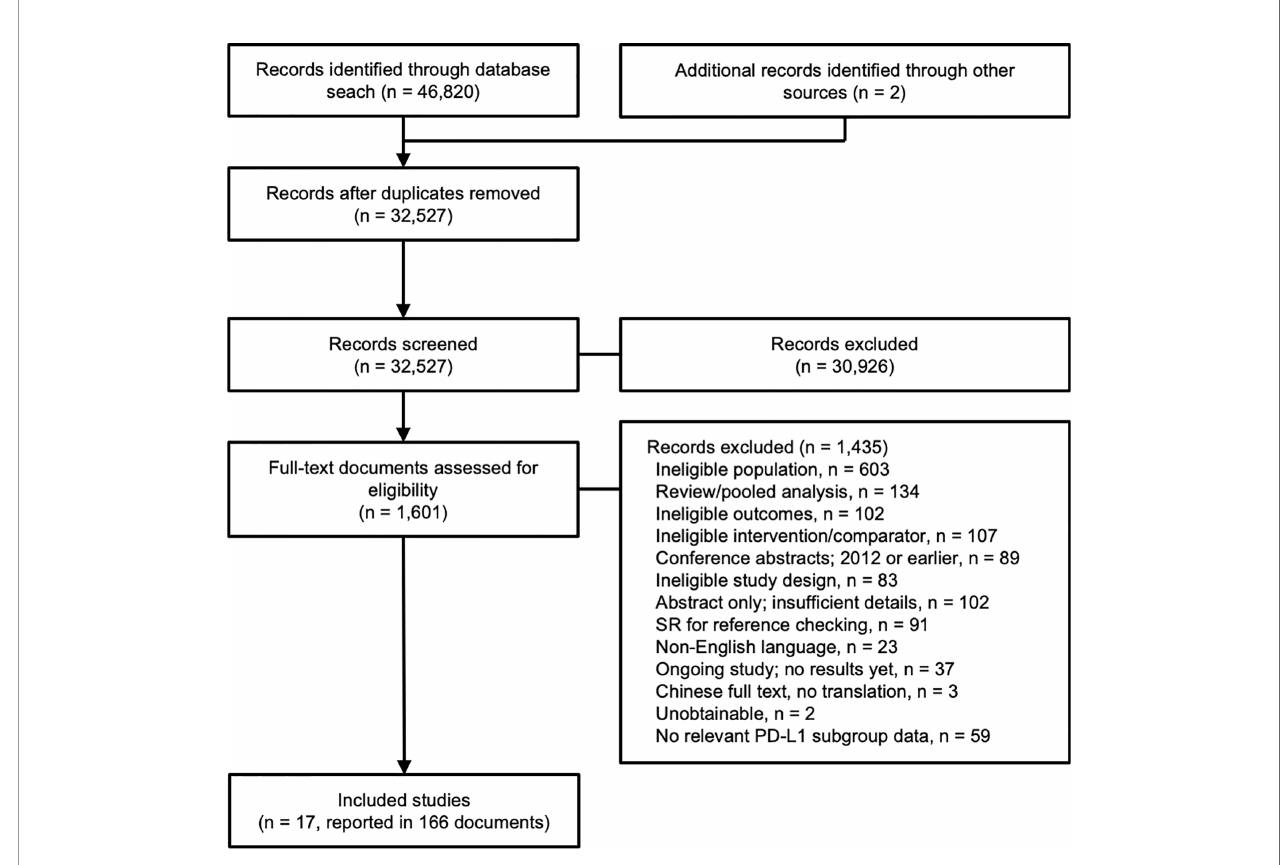
FIGURE 1 | Study fl ow